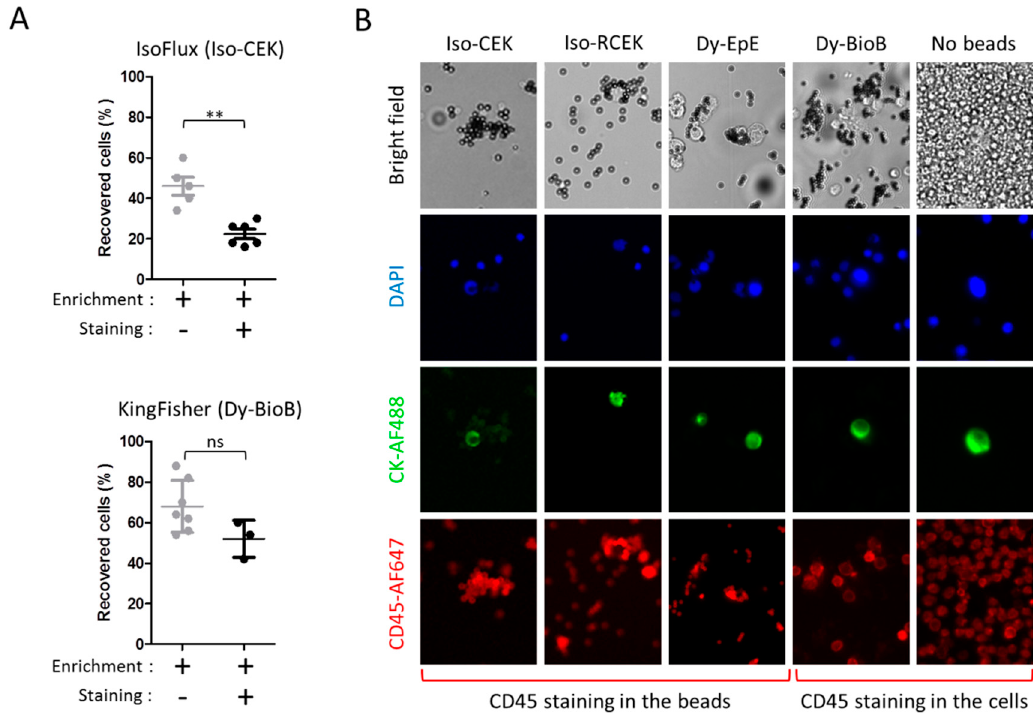
Figure 5. Impact of staining in the recovery and identification of cells spiked in mimicked-DLA products. ( A ) Impact of the staining procedure. (Upper panel) Recovery of 50 pre-labeled CAPAN-1 cells with Iso-CEK beads, with and without the subsequent staining procedure performed according to the IsoFlux protocol. For this experiment, the fluorescent-conjugated antibodies in the respective protocols were replaced by non-conjugated mouse IgG isotype control. (Lower panel) Recovery of 50 pre-labeled CAPAN-1 cells with Dy-BioB MAX beads, with and without a subsequent staining procedure performed automatically in the KingFisher (protocol WuDuo Staining ). ( B ) Impact of beads in the immunofluorescence identification of spiked and hematogenous cells. Cells enriched with the Iso-CEK, Iso-RCEK, Dy-EpE, and Dy-BioB beads were stained with DAPI, and AF488-conjugated CKs, and AF647-conjugated CD45 mouse monoclonal antibodies.